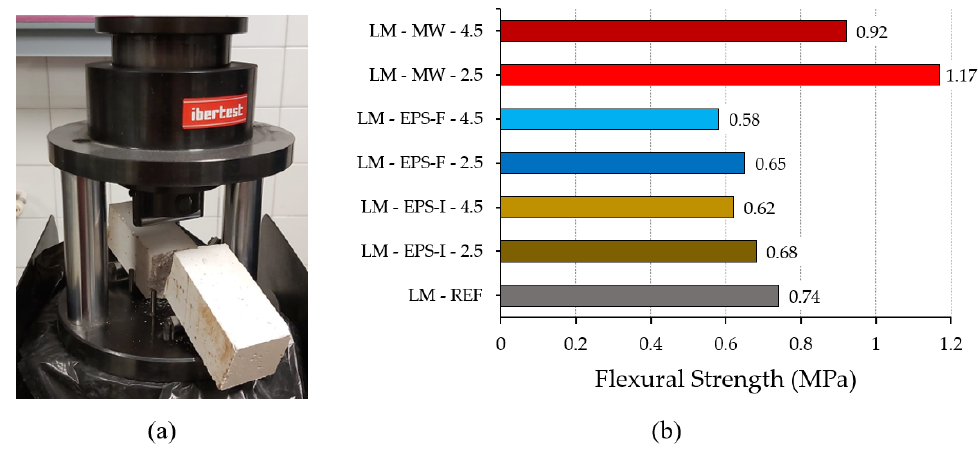
Figure 3. Flexural strength test. ( a ) IBERTEST press model AUTOTEST 200-10SW; ( b ) results obtained for the different batches.